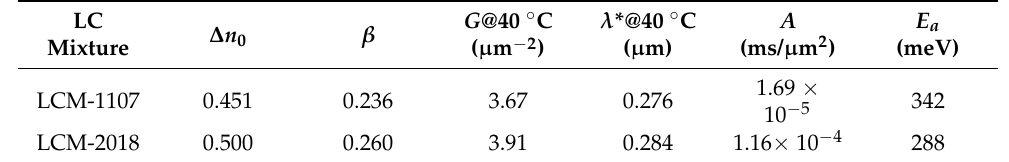
fitting the experimental data with Equation (1), whose results are listed in Table 2. Table 2. Fitting parameters obtained through Equations